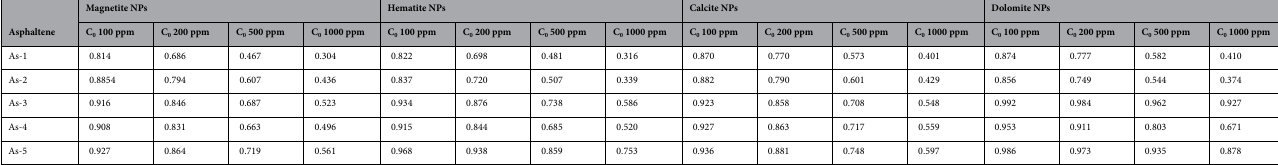
Table 3. Results of Langmuir separation factor (R L